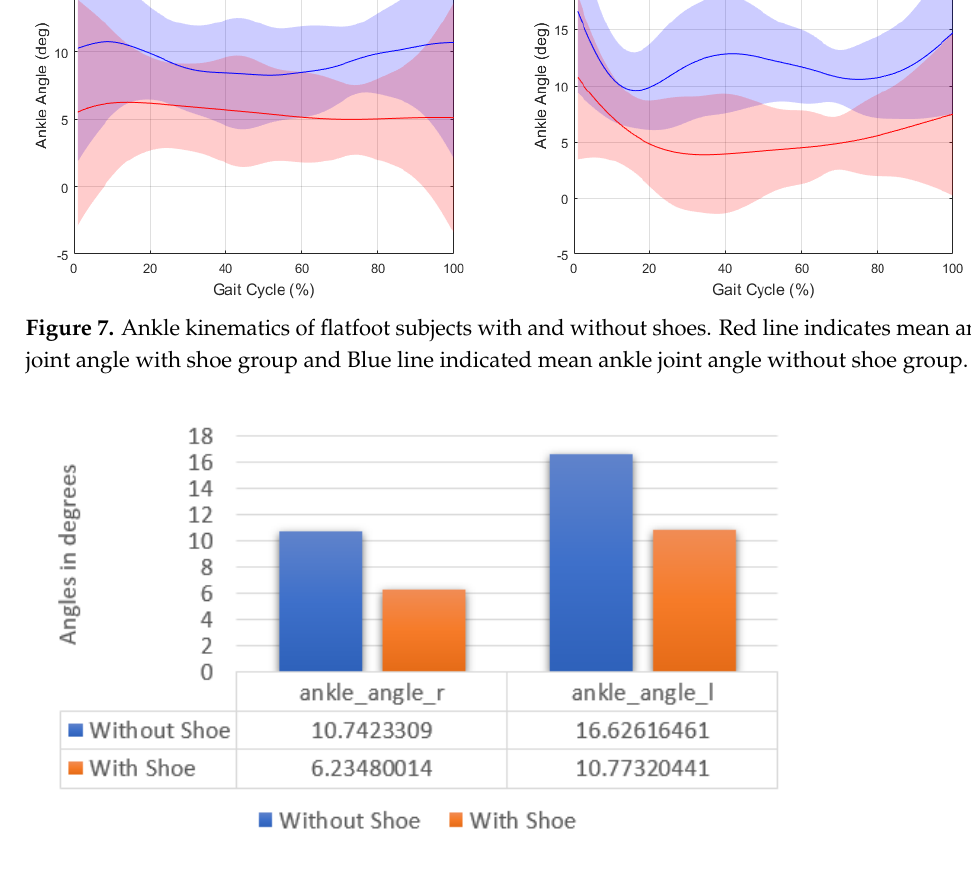
Figure 8. Maximum ankle (dorsiflexion) joint angles of flatfoot subjects with and without shoes. r-right;